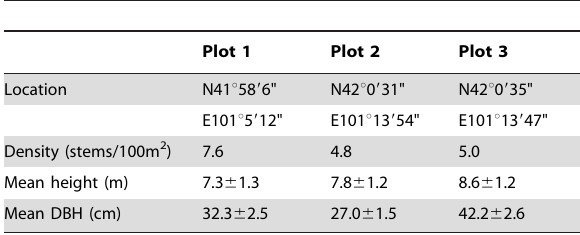
Table 5. Density, height and diameter at breast height of seed-dispersing P. euphratica trees in the three seed-dispersal study plots.